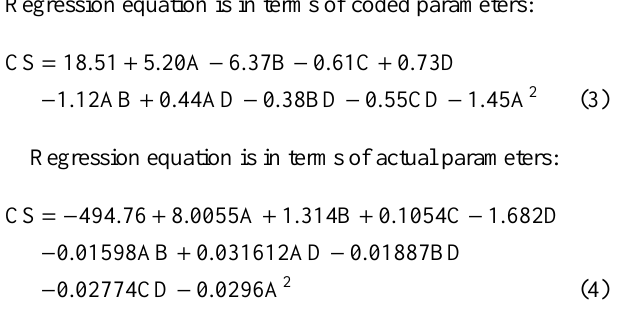
Figure 5 Residuals plot for RoC